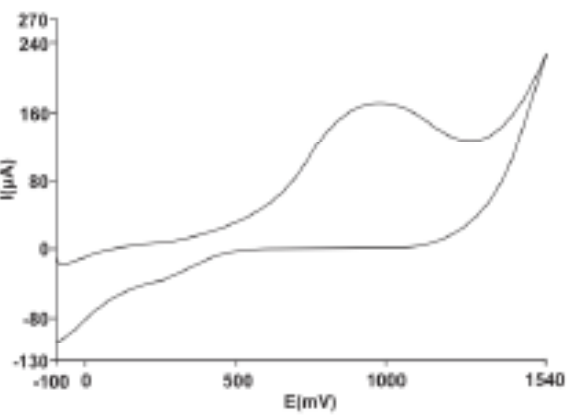
Figure 3: Cyclic voltammogram obtained at the Pt ring electrode Mettler-Toledo, for 500 mg L -1 sulfite using as electrolyte 0.1 mol L -1 KCl; scan rate=50 mV s -1